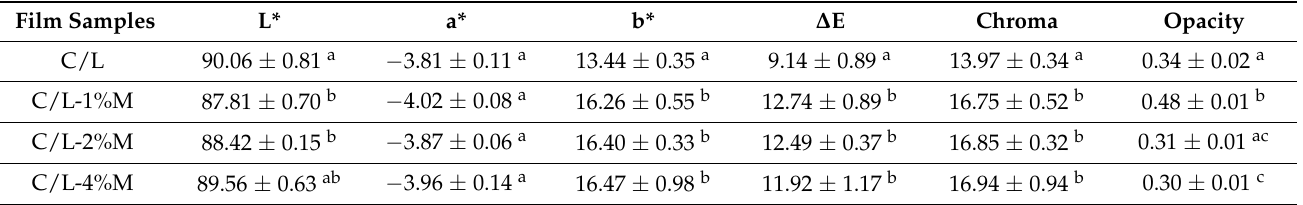
Table 2. The optical properties of carboxymethyl chitosan/locust bean gum films incorporated with Melissa officinalis L. essential oil